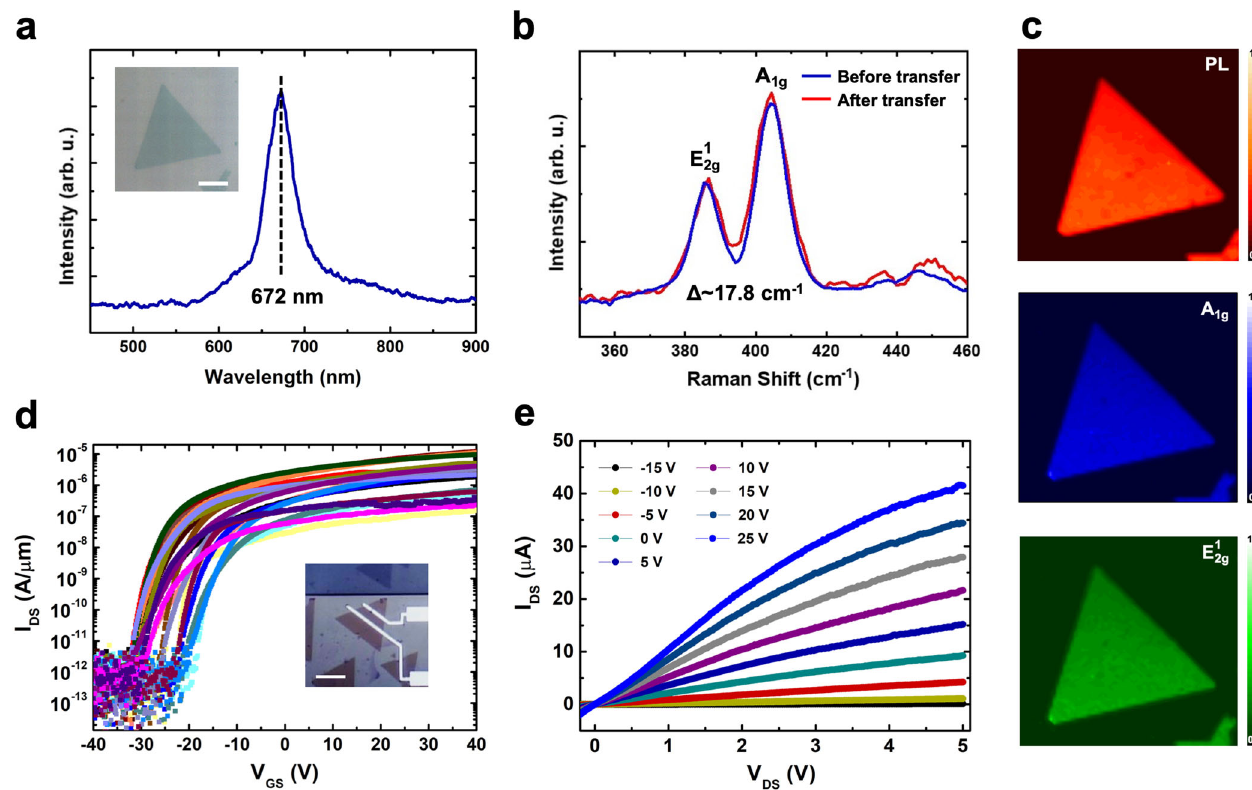
Fig. 3 Material characterization and electrical performance of back-gated MoS 2 FET on SiO 2 /Si. a Photoluminescence (PL) spectrum of MoS 2 . The inset shows a representative CVD-grown MoS 2 fl ake used in this work. Scale bar, 5 μ m. b Raman spectra showing A 1g and E 1 characteristic peaks of MoS 2 before and after wet-transfer. c PL mapping for A exciton peak intensity at 1.85 eV and Raman mapping for the peaks, all of which are obtained from the MoS 2 triangle shown in the inset of a . d Measured transfer characteristics of 23 back-gate A 1g and E 1 2g MoS 2 FETs fabricated in different process batches ( V DS = 1 V). Scale bar, 5 μ m. e Measured output characteristics of a back-gated MoS 2 FET at V GS = − 15 V to 25 V in 5 V